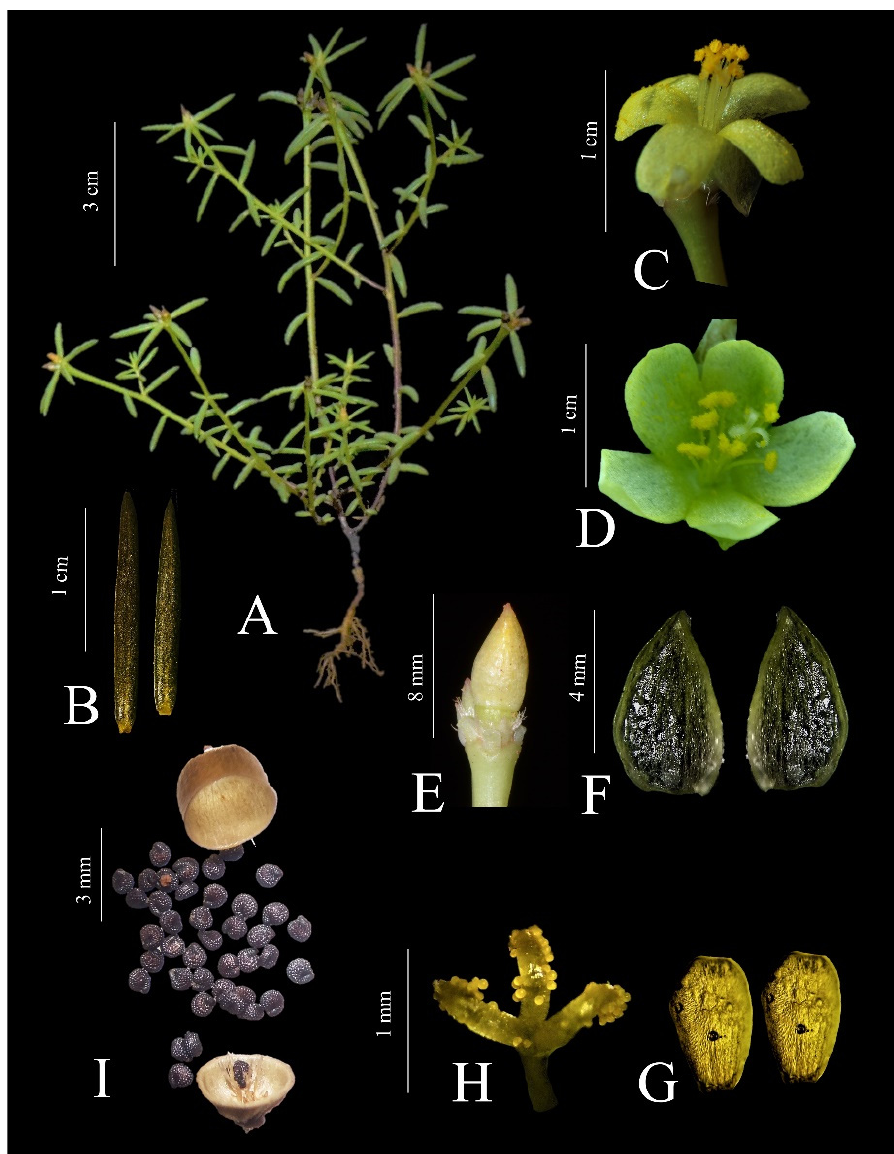
Figure 3. Portulaca badamica S.R. Yadav and Dalavi. ( A ) Habit; ( B ) leaves; ( C , D ); chasmogamic flowers; ( E ) cleistogamic flower; ( F ) sepals; ( G ) petals; ( H ) stigma; ( I ) dehisced pyxis with seeds. Habitat: Plant shows a very discrete population in moist sandy